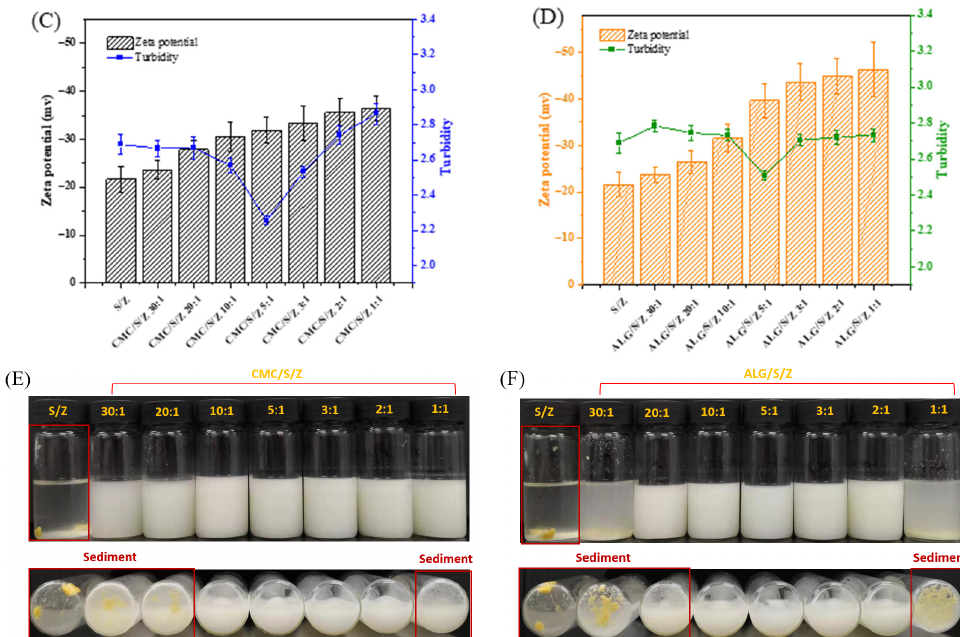
Figure 2. Particle size, PDI, zeta potential and turbidity of CMC/S/Z and ALG/S/Z with different zein to polysaccharide mass ratios at pH = 4. Particle size and PDI ( A , B ). Zeta-potential and turbidity ( C , D ). The photograph of each group appearance ( E , F ).